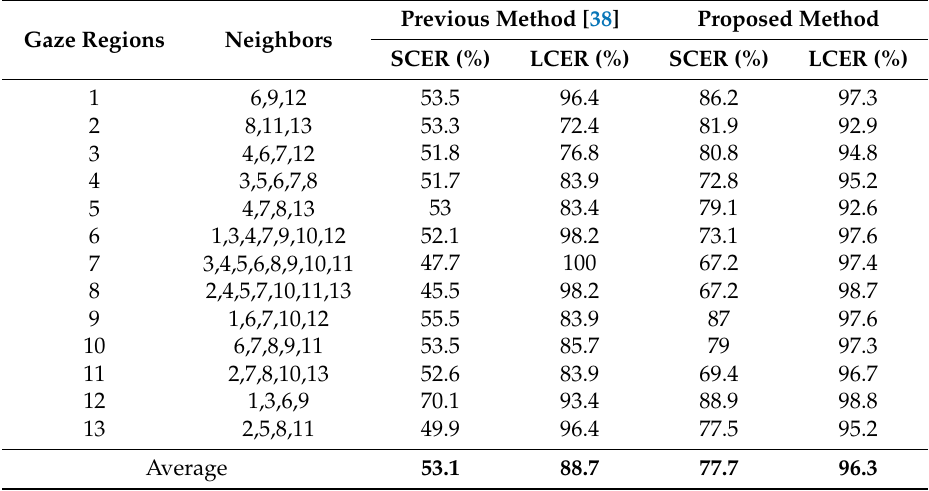
Table 13. SCER and LCER of previous [38] and proposed methods on CAVE-DB.